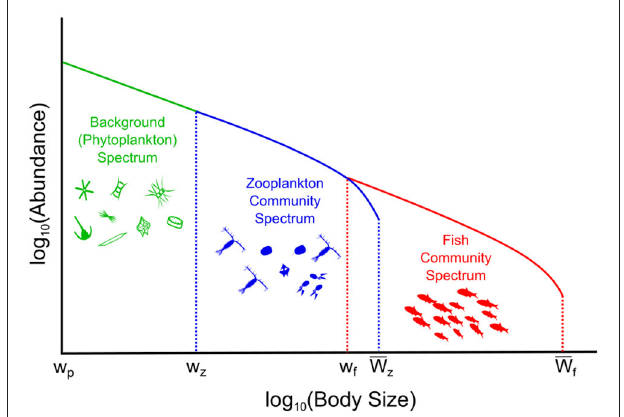
FIGURE 1 | Conceptual illustration of the phytoplankton– zooplankton–fish system. The background (phytoplankton) spectrum is held constant, the dynamic zooplankton, and fish community spectrums are governed by Equation (1) and the Equations in Table 2